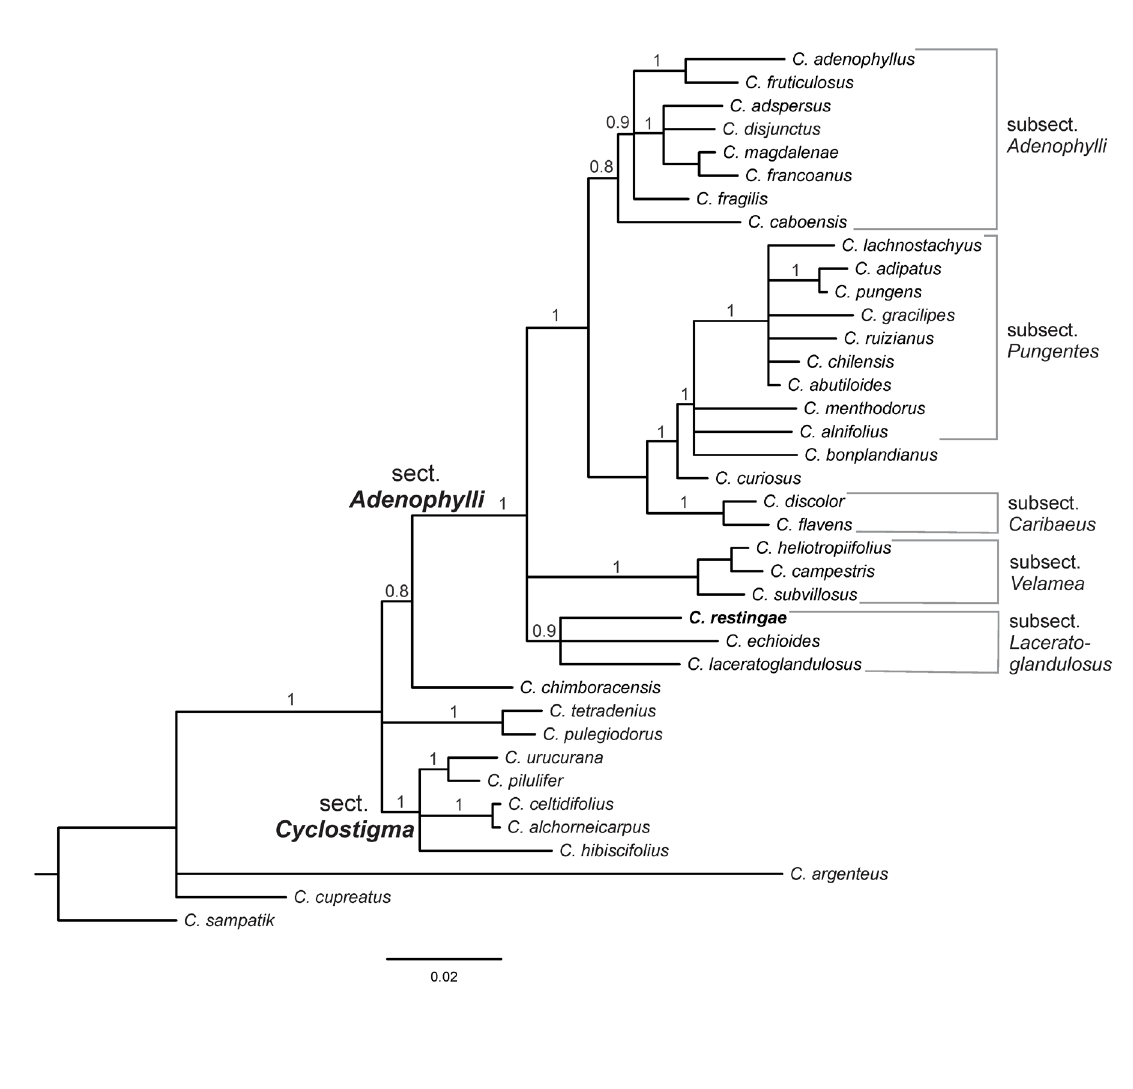
Fig. 1. Bayesian majority consensus phylogram of ITS nuclear data from a selection of taxa of Croton L. including an accession of Croton restingae Sodré & Riina sp. nov. The relevant clades are named. Values above the branches are Bayesian posterior probabilities. The scale bar indicates the average number of nucleotide substitutions per